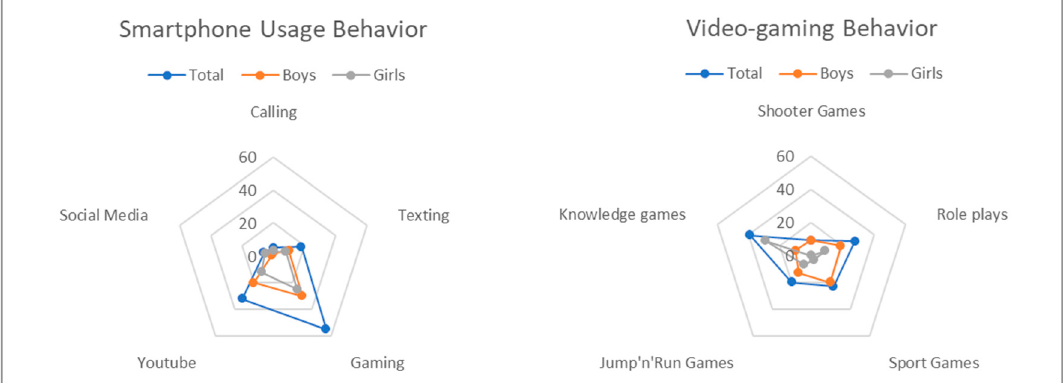
Figure 2. Usage behavior for single applications in gaming and smartphone use for the total sample and divided by gender.